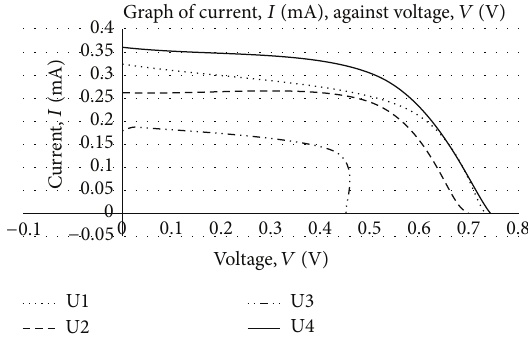
Figure 10: The basic molecular structure of anthocyanin and the binding with TiO 2 [5].